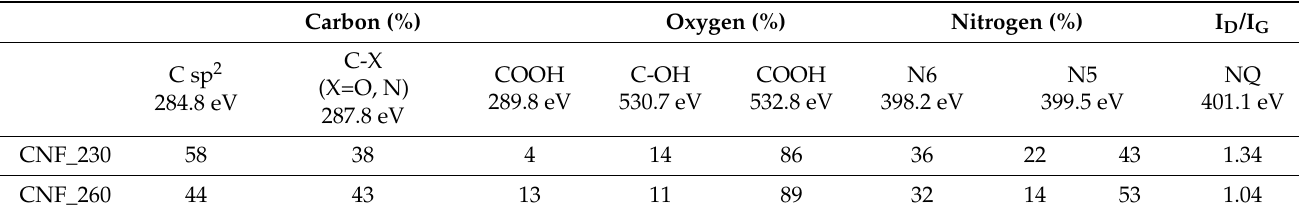
Figure 6. XPS spectra of CNF_230 (C 1s ( i ), O 1s ( ii ), and N 1s ( iii )) and CNF_260 (C 1s ( iv ), O 1s ( v ), and N 1s ( vi )). Table 1. Characteristic features from XPS and Raman analysis of CNF_230 and